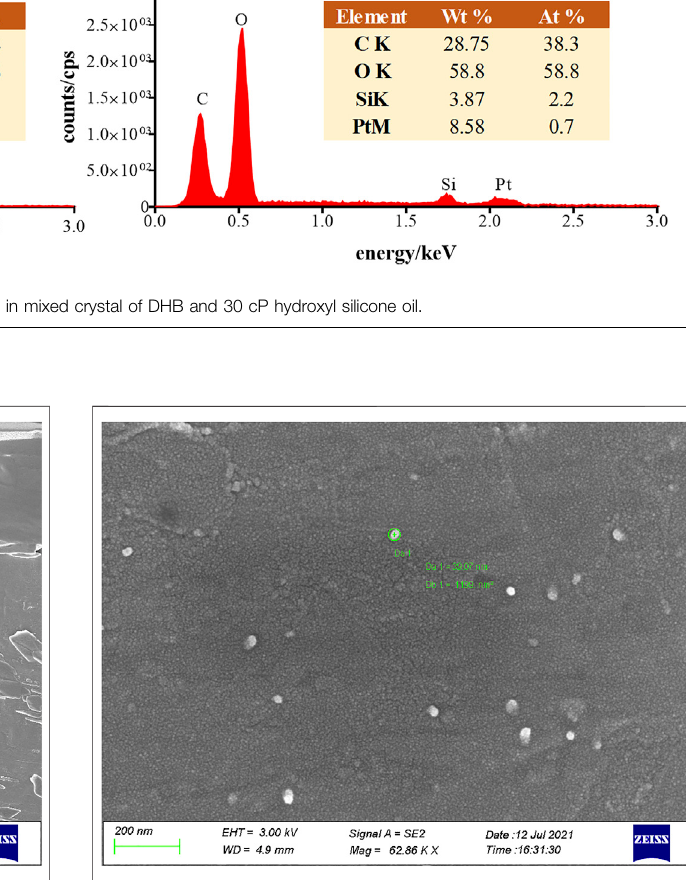
FIGURE 5 | SEM image (at the 2 μ m level) of the mixed crystal of DHB and 30 cP hydroxyl silicone oil.